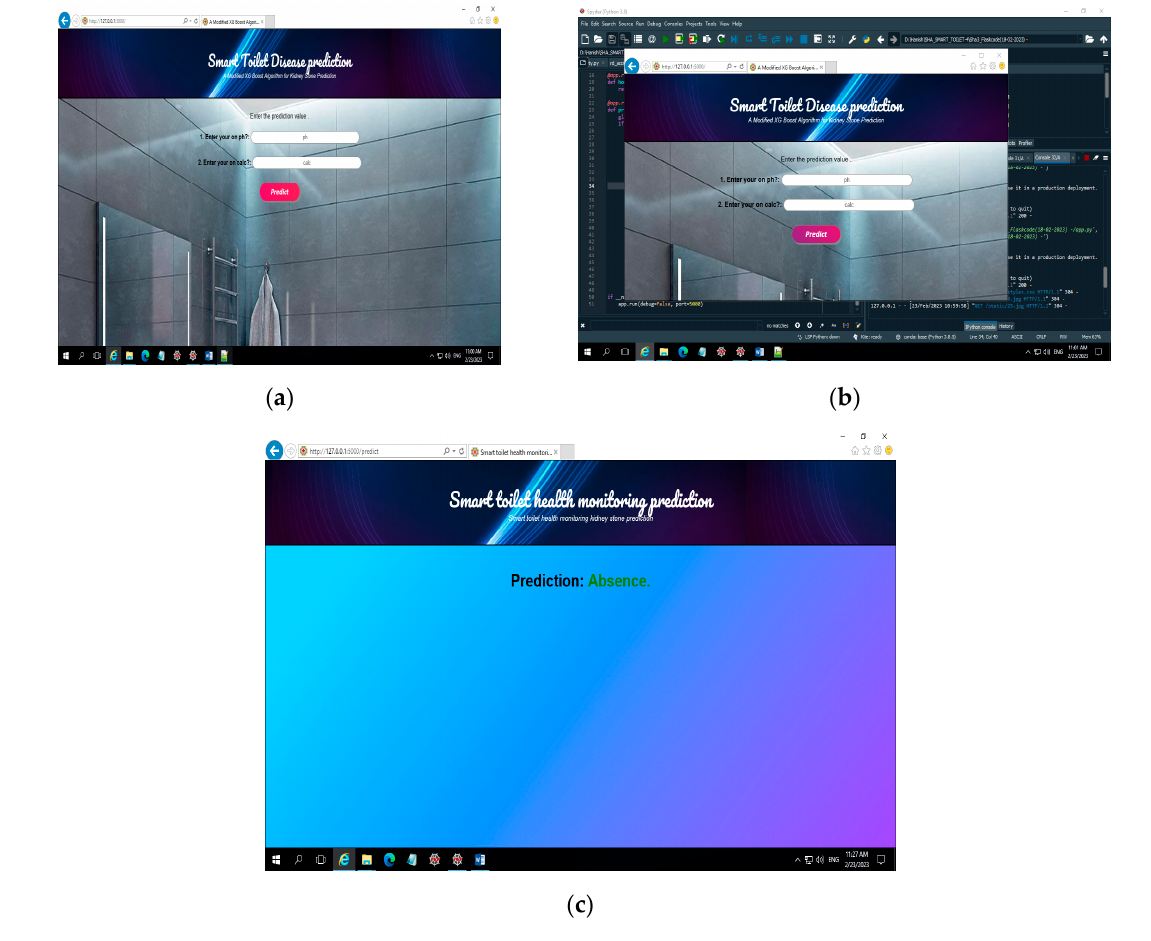
Figure 7. ( a – c ). Implementation results.